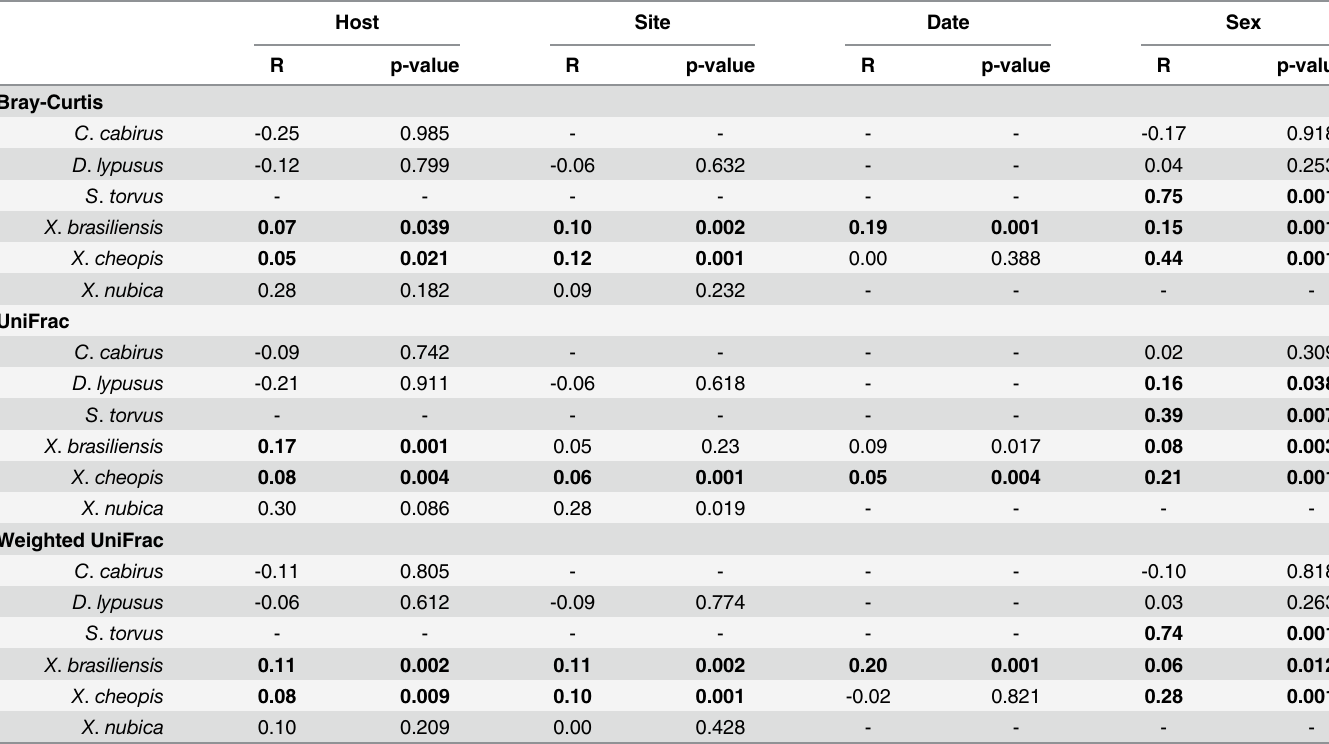
Table 5. Analysis of Similarity of bacterial communities (Within Flea